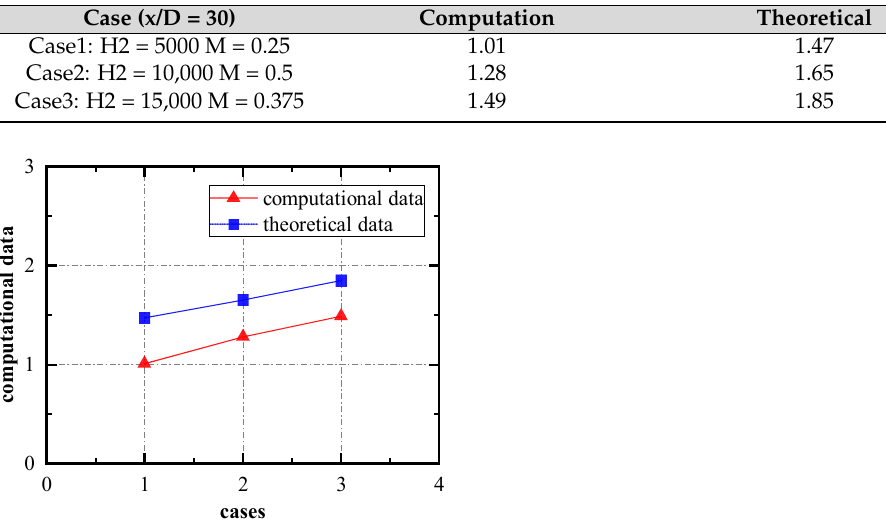
Figure 5. Computational and theoretical data of ∆ T 1 / ∆ T 2 under different conditions.